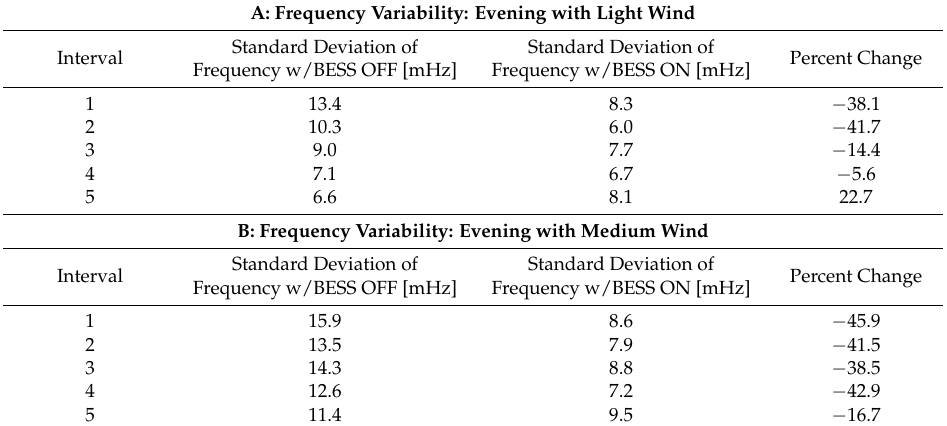
Table 2. The standard deviation of the 20-min intervals with BESS OFF versus 20-min periods with BESS ON, along with the percent change between intervals, for the switching experiments shown in Figure 6. A: Results for the evening with light winds; B: Results for an evening with medium winds. A: Frequency Variability: Evening with Light Wind